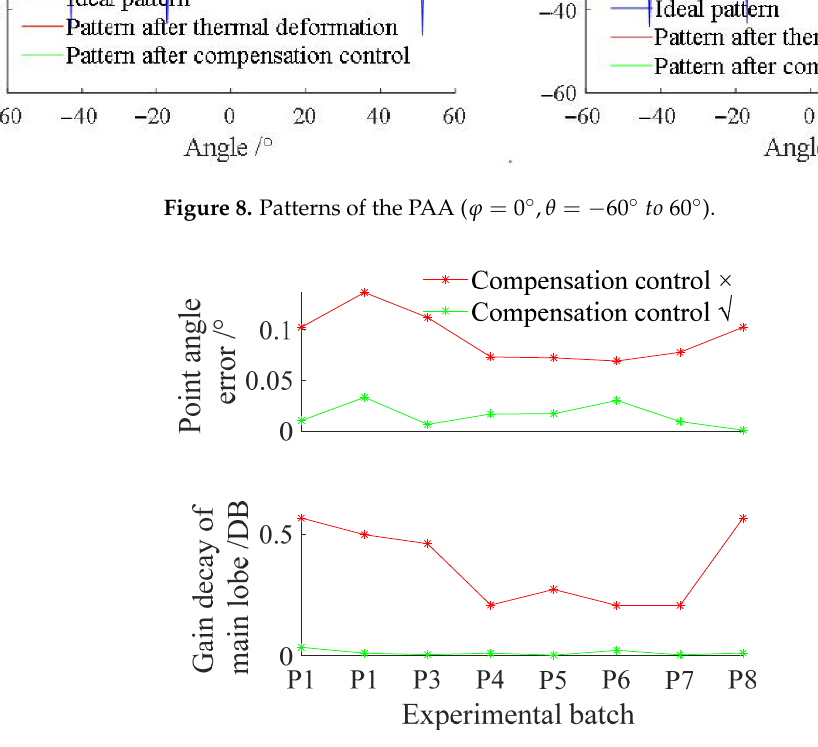
Figure 9. Compensation control effects .